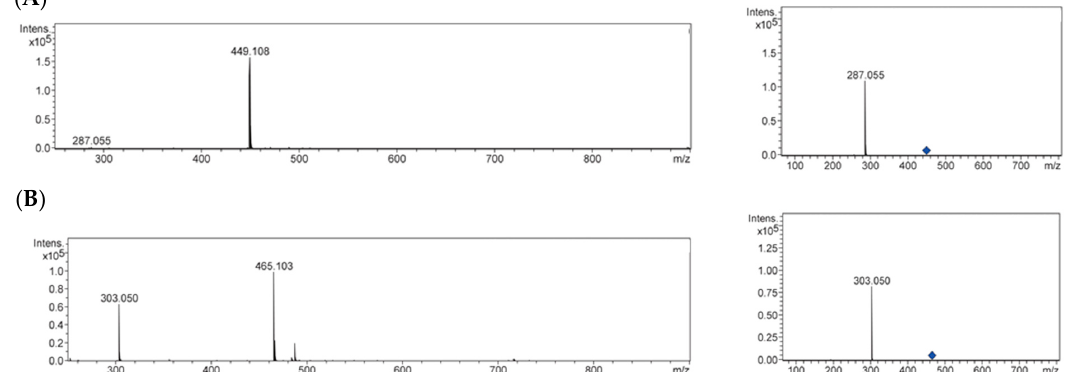
Figure 4. UHPLC-QqTOF-MS analyses of antiglycative components in Persicaria hydropiper. ( A ) Mass spectrum (left panel) and MS/MS spectrum (right panel) of peak 1. ( B ) Mass spectrum (left panel) and MS/MS spectrum (right panel) of peak 2.